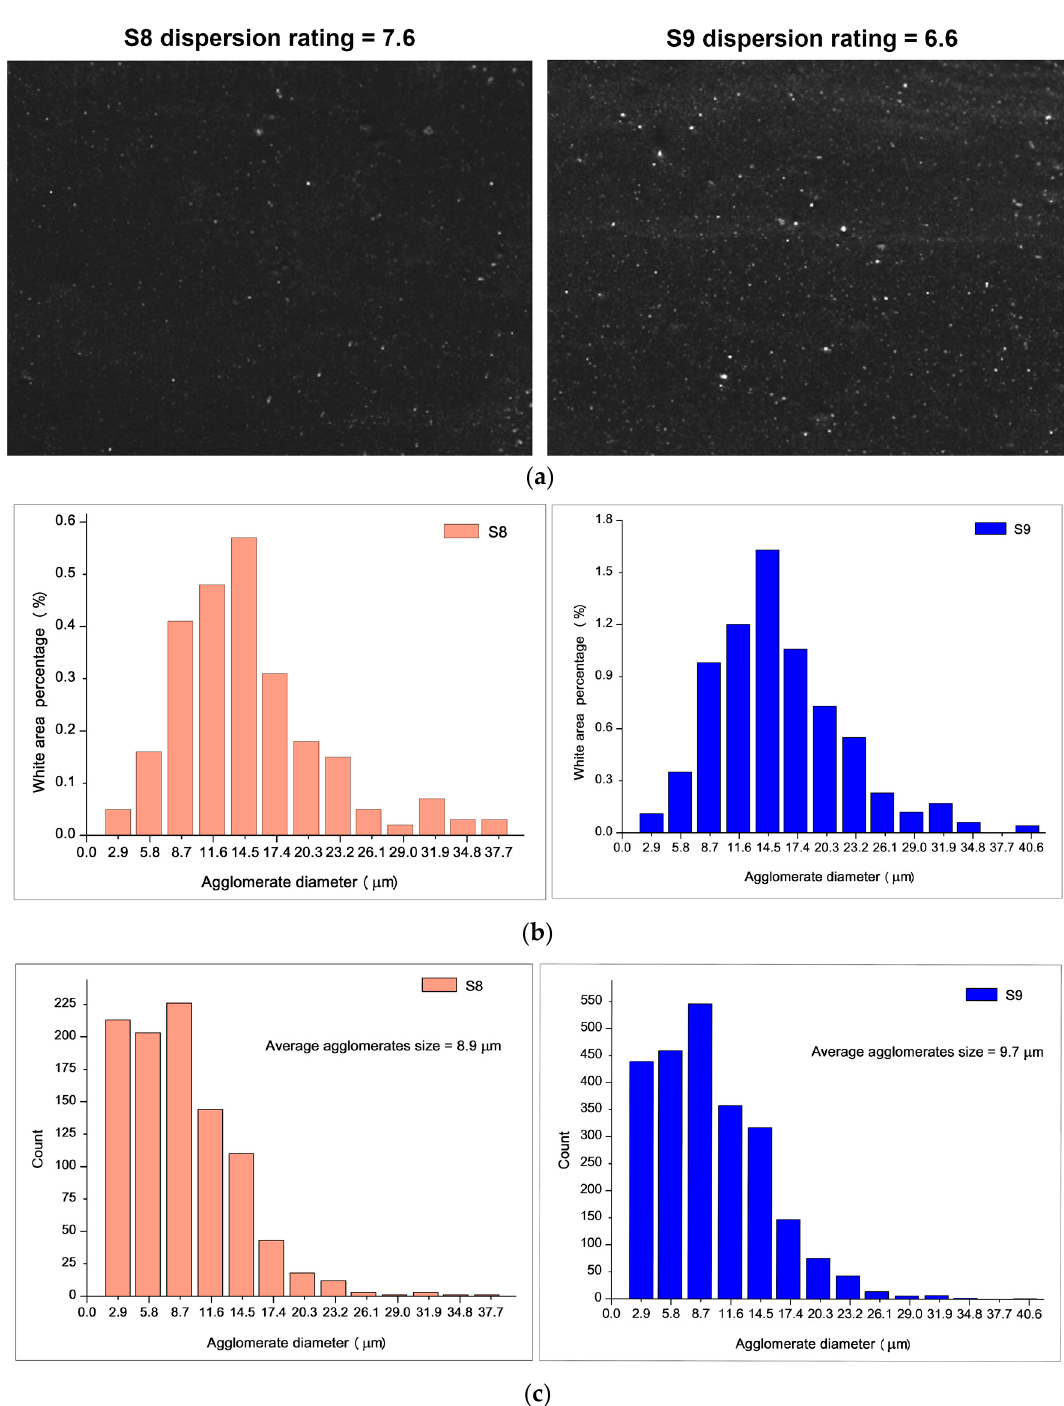
Figure 11. Results of filler dispersion tests. ( a ) Dispersion rating of S8 and S9, ( b ) histogram of white area percentage for S8 and S9, ( c ) histogram of agglomerates for S8 and S9.